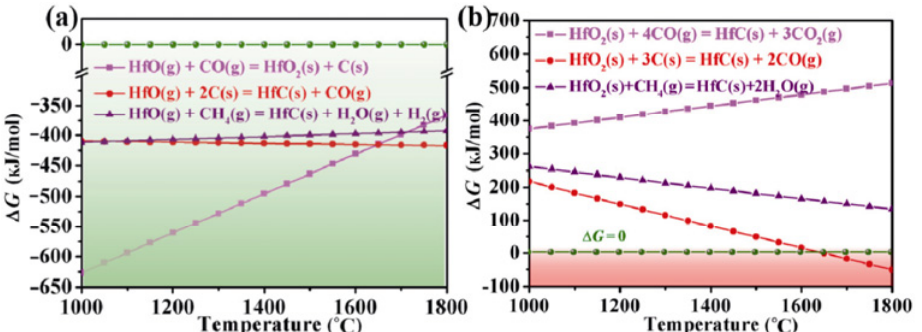
Fig. 5 Ellingham diagrams of possible chemical reactions of (a) HfO and (b) HfO 2 with C, CH 4 , and CO during annealing of pyrolysis product at temperatures of more than 1000 ℃ .